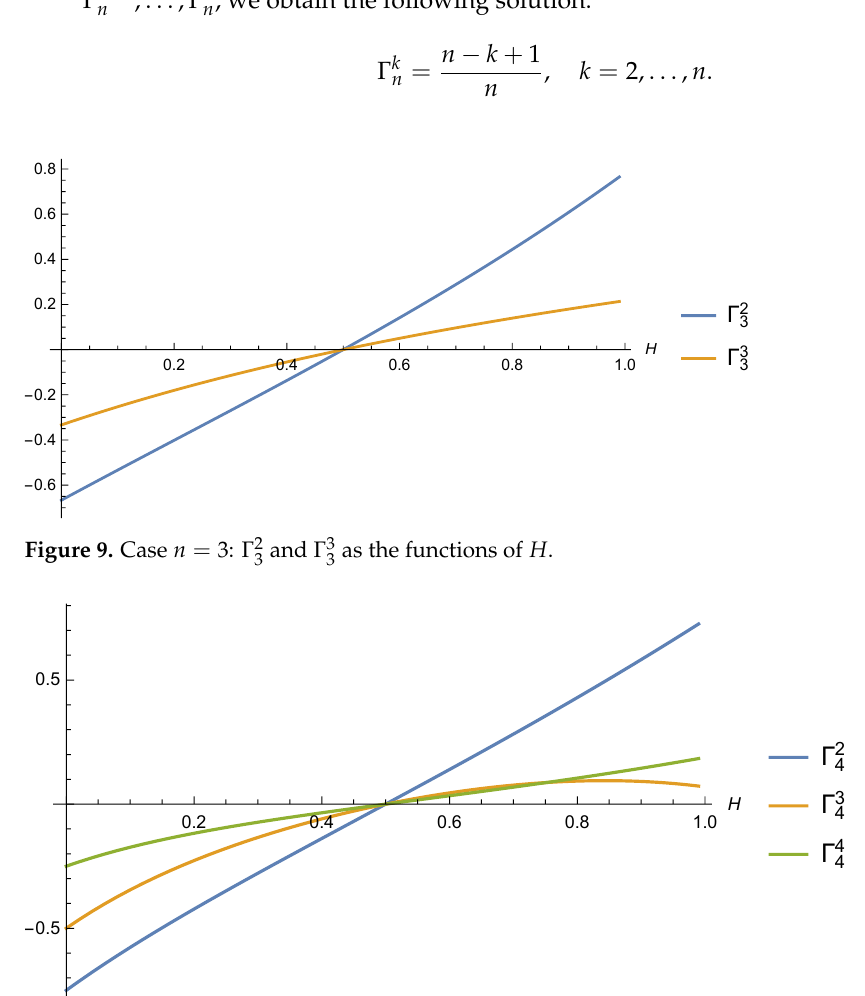
, Γ 3 , and Γ 4 as the functions of H 4 4 4